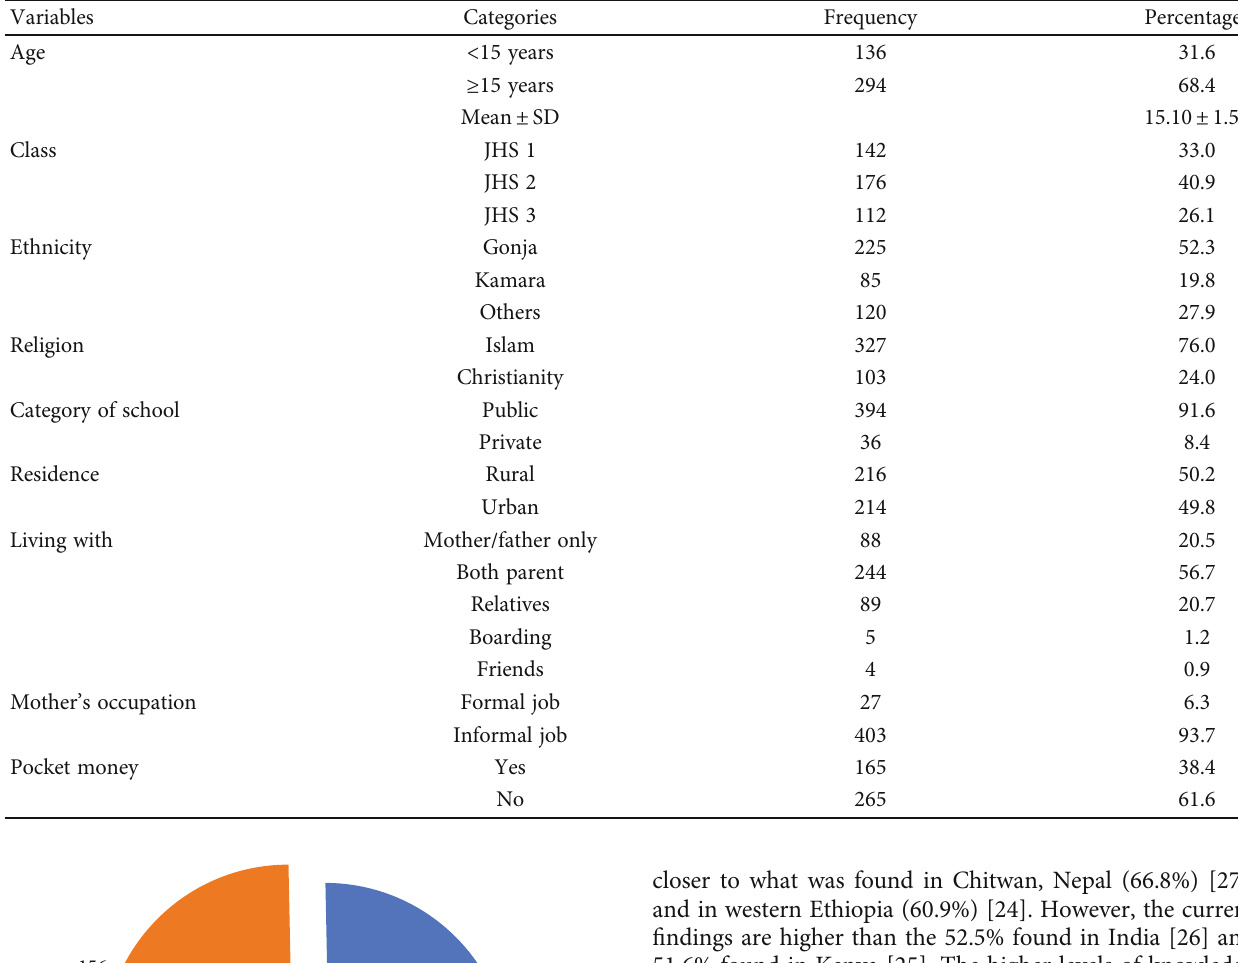
Table 1: Socio-demographics of the girls ( n =430).